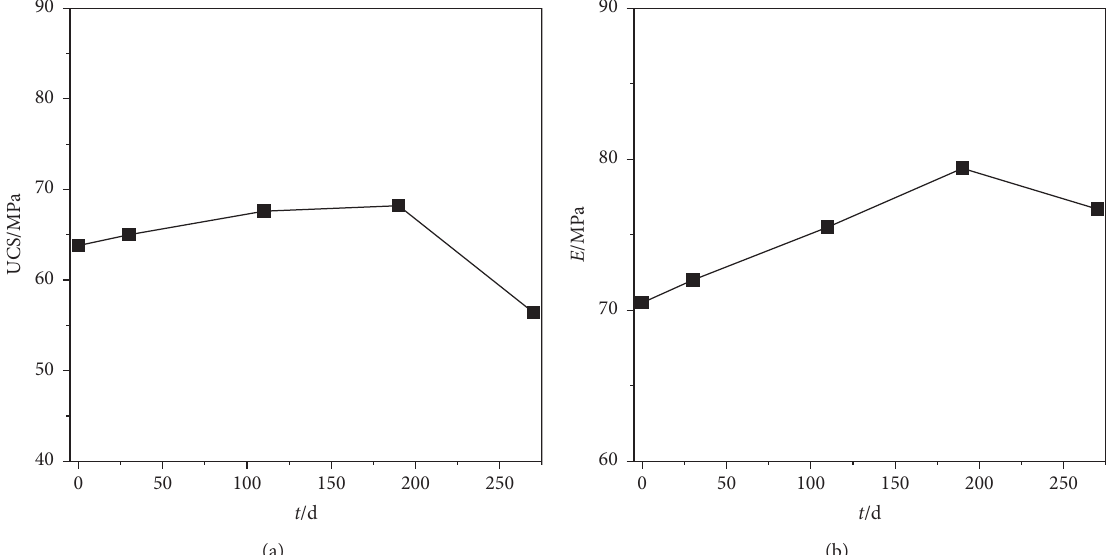
Figure 4: The variation of (a) uniaxial compressive strength and (b) elasticity modulus of C3-7 with the corrosion time.